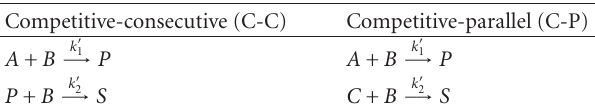
Table 1: Classic mixing sensitive reaction schemes. Competitive-consecutive (C-C) Competitive-parallel